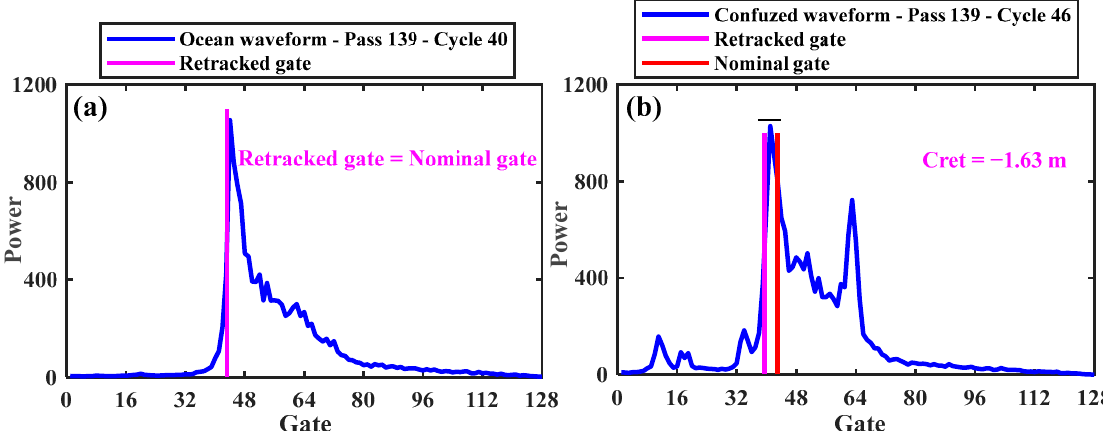
Figure 4. Retracking the full original waveform using threshold retracker with 30% threshold for pass 139 over Persian Gulf; ( a ) is an ocean-like and ( b ) is a corrupted waveform.